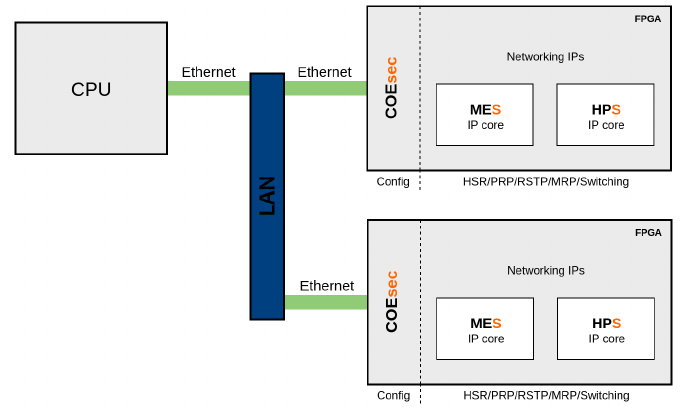
Figure 2. CPU-FPGA communication. Networking CPU-less Intellectual Properties (IPs) implemented in both FPGAs can be securely configured by a CPU located in the same network.